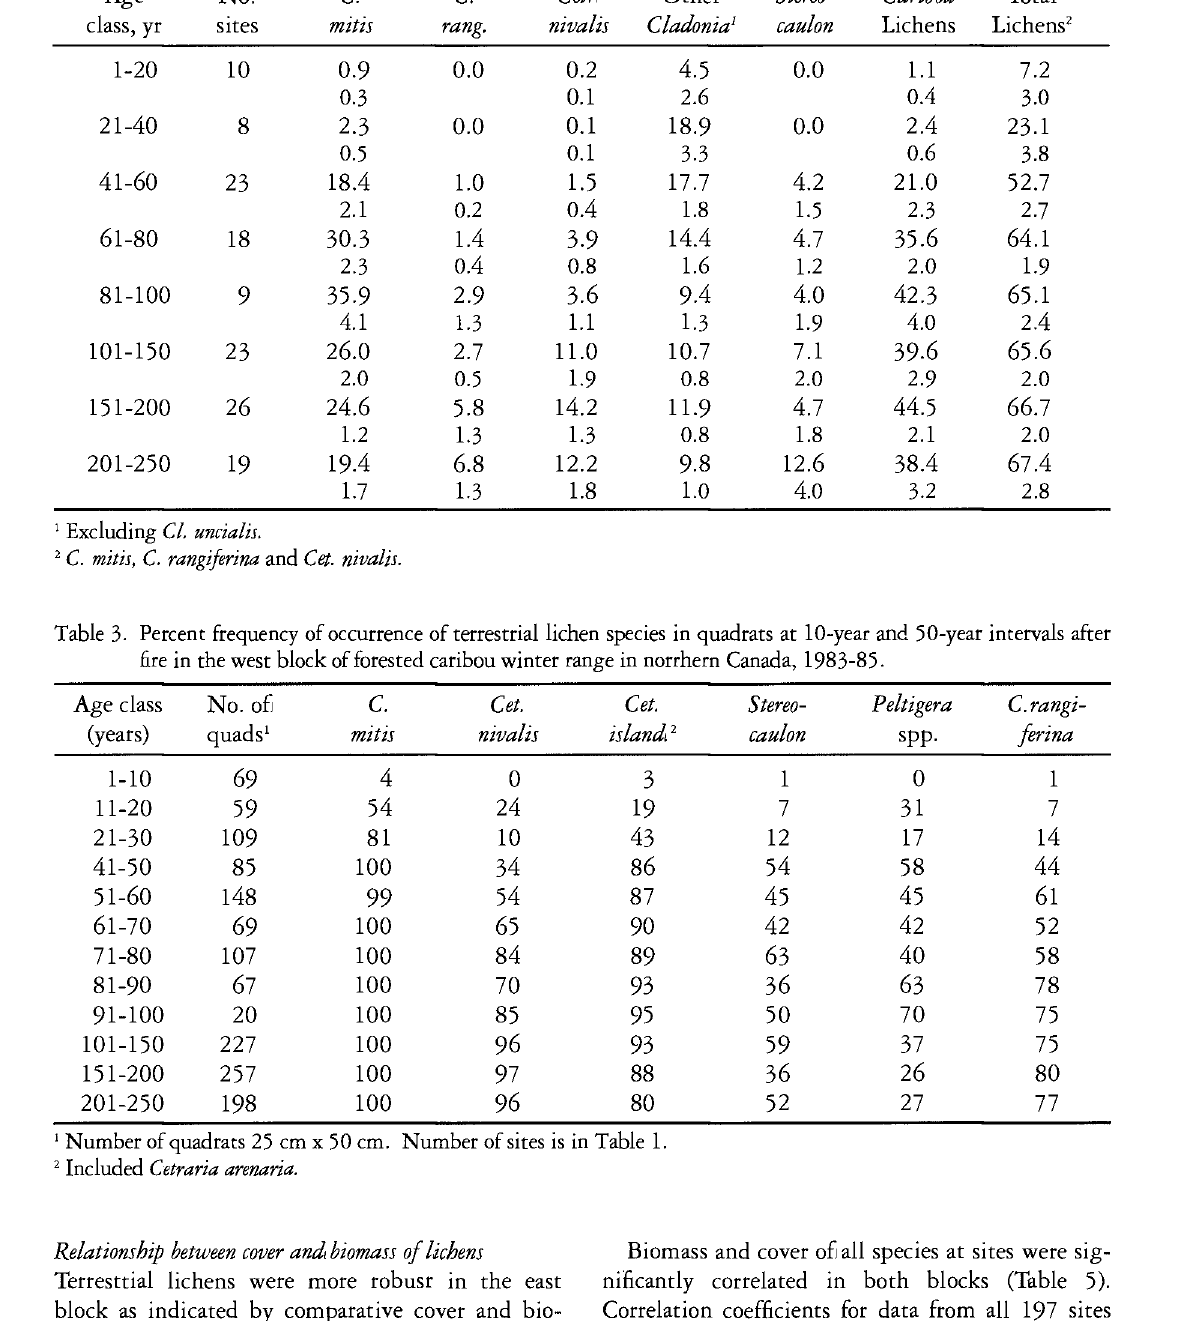
Table 2. Mean percent cover of lichens in eight age classes of forest sampled in the west block of the winter range of the Beverly herd of caribou, 1983-85. Standard errors are in smaller print below each mean. Age N o. C. C. Cetr. Other Stereo Caribou Total class, yr sites mitis rang. nivalis Cladonia 1 caulon Lichens Lichens 2 1-20 21-40